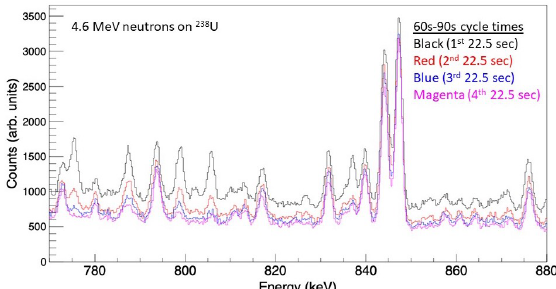
Figure 5. Preliminary data showing the presence of short-lived fission products for a longer 60 s irradiation / 90 s measurement